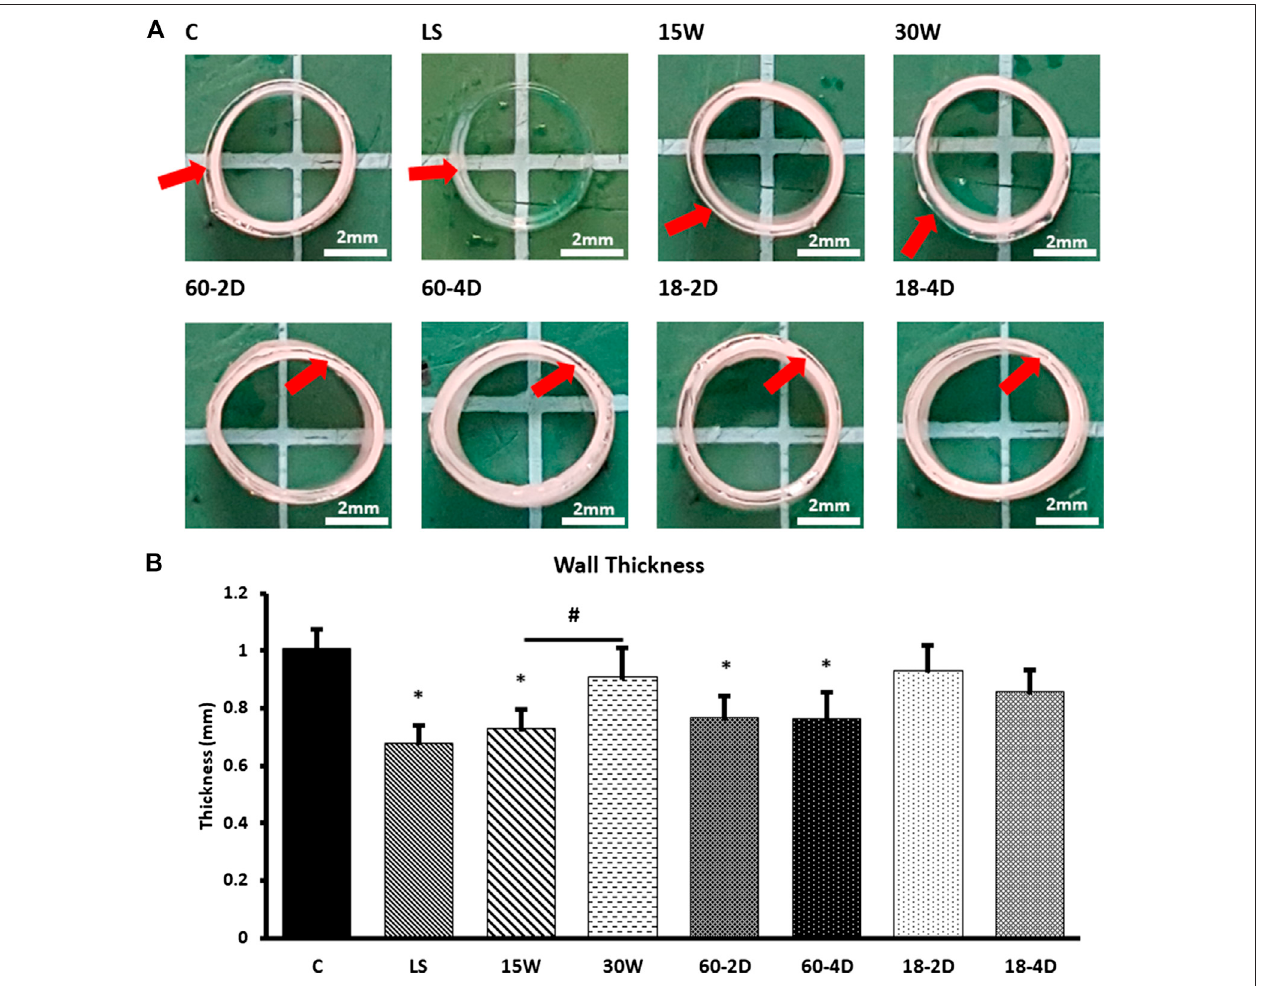
FIGURE3| Physicalcharacterizationoftheexperimentalgroups. (A) Cross-sectionalimages.Redarrowsusedtoidentifydifferenceleveloftransparencybetween layers within a sample. (B) Wall thickness of the samples for different number of layers. (C) Wall thickness of the samples. *Indicates p ＜ 0.05 with respect to control group. # Indicates p ＜ 0.05 between the groups being compared. n (cid:2) 9 for all samples.